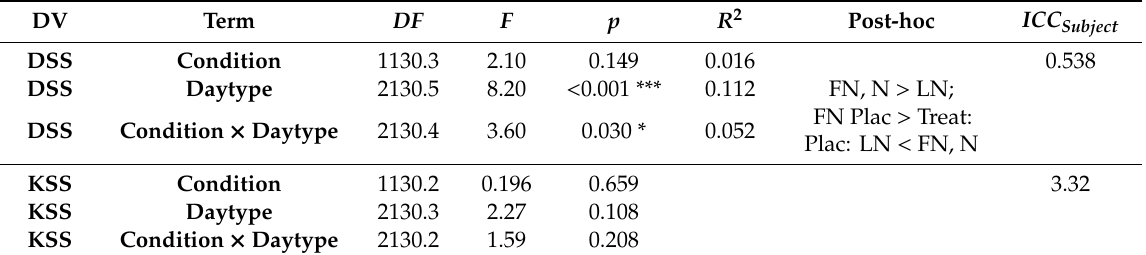
Table A4. Results of the LMM analyses of sleepiness parameters (DSS and KSS) after